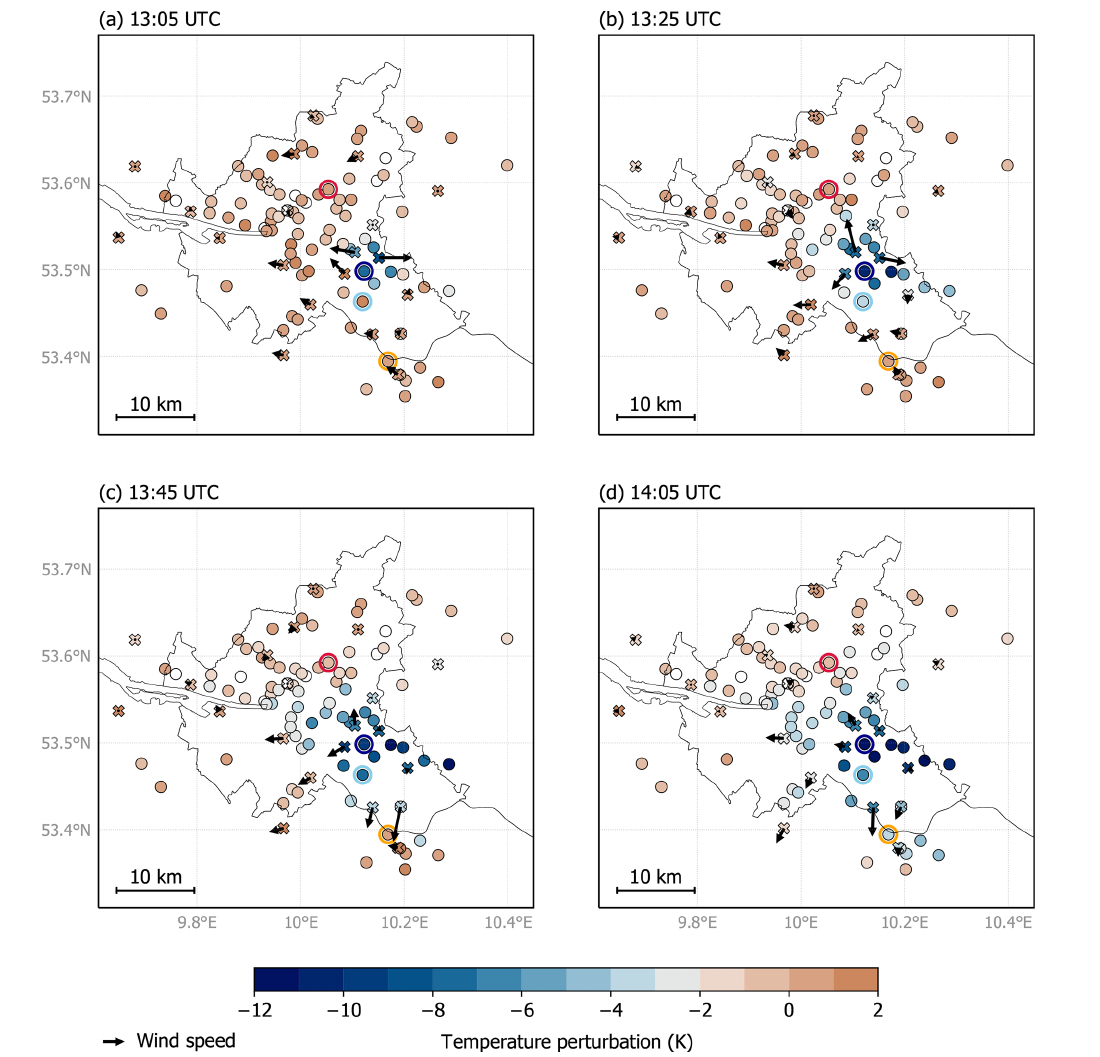
Figure 9. Perturbation in air temperature since 12:30UTC from (a) 13:05UTC to (d) 14:05UTC observed by APOLLO (circles) and WXT stations (crosses) during a cold pool event on 10 August 2020. Bluish colors mark stations inside the cold pool defined by a temperature perturbation stronger than − 2K (color map by Crameri, 2018; Crameri et al., 2020). Black arrows indicate instantaneous wind speed and direction observed by WXT stations. The length of the reference arrow corresponds to 5ms − 1 wind speed. The four highlighted stations refer to the respective data illustrated in Fig.